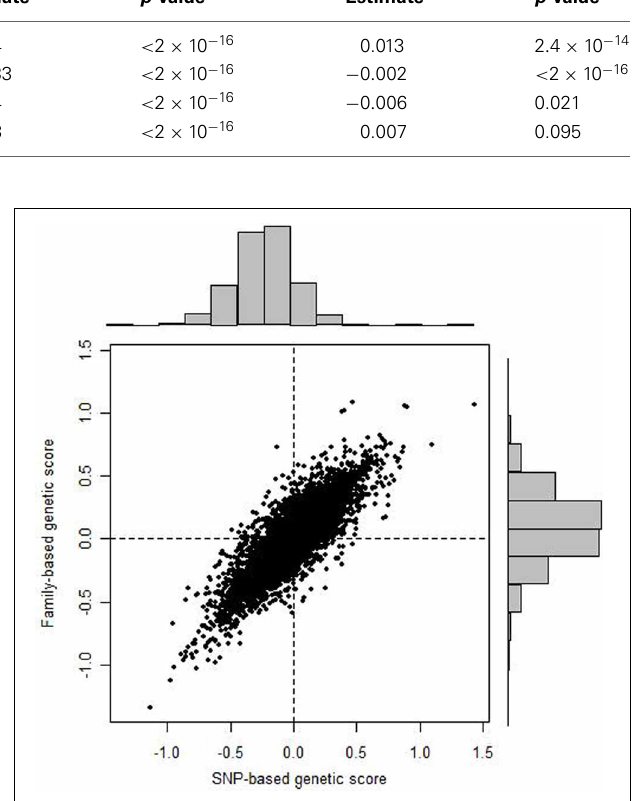
FIGURE 2 | Scatter plot of pedigree-based vs. SNP-based values of FEV 1